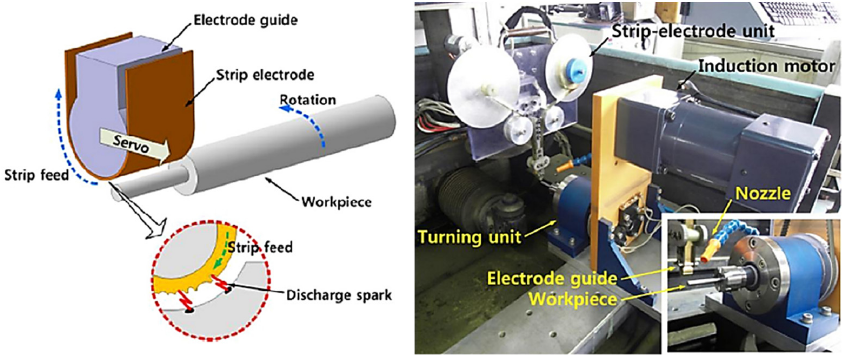
Figure 6. Schematic diagram of Strip-TET along with Strip-TET setup (Reprinted/Adapted with permission from [30]. 2013, Elsevier. ©).